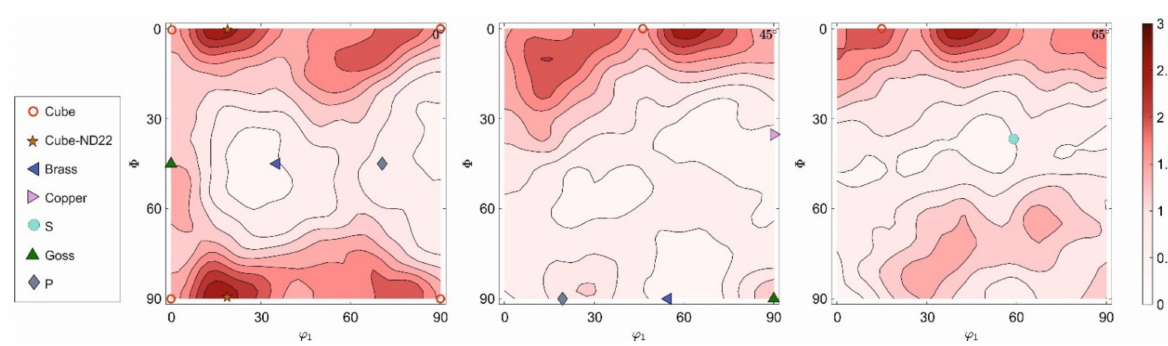
Figure A28. ODF data of the soft annealed HFe-HMn cast under NR-C conditions, homogenized at 500 ◦ C and cold rolled to a CRD of 63% plotted in sections of ϕ 2 and including the ideal orientations of specific texture components; left: ϕ 2 = 0 ◦ , middle: ϕ 2 = 45 ◦ and right: ϕ 2 = 65 ◦ .